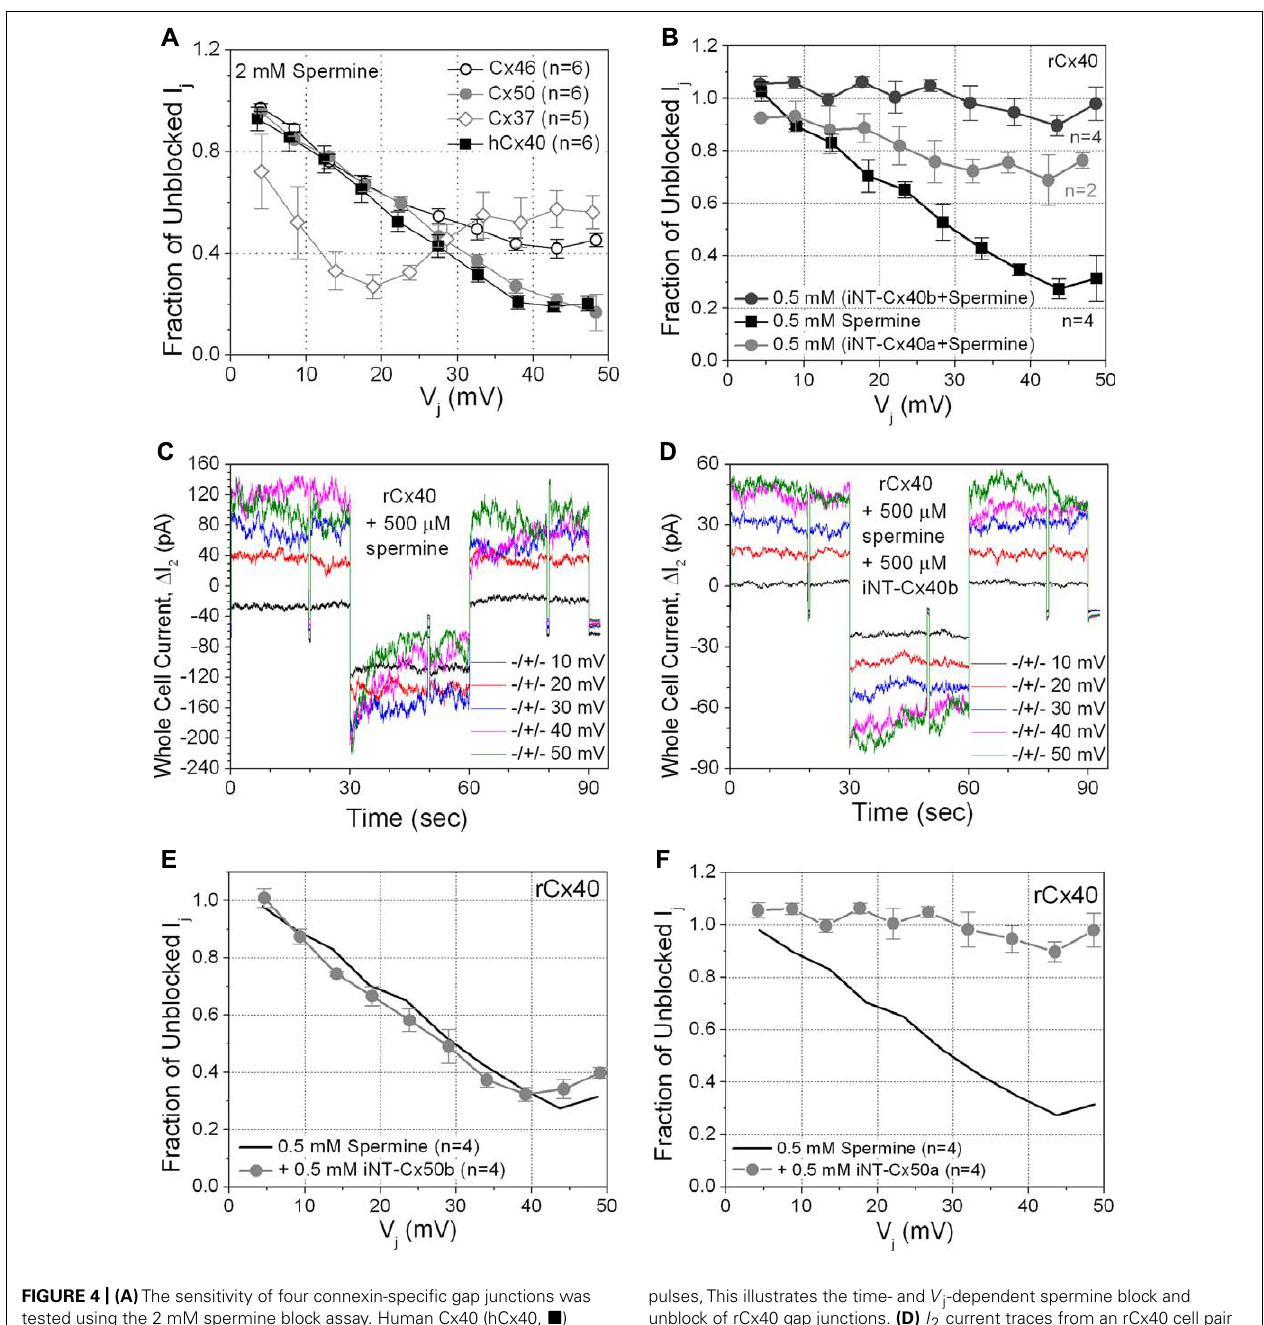
FIGURE 4 | (A) The sensitivity of four connexin-specific gap junctions was tested using the 2 mM spermine block assay. Human Cx40 (hCx40, (cid:2) ) displayed similar V j -dependent sensitivity to spermine as rCx40 despite the • ◦ (cid:8) ), Cx46 ( ), and Cx50 ( ) gap junctions were all N9 substitution. Cx37 ( ≥ 60% inhibited by spermine.The maximum inhibition of Cx37 g j occurred at + 20 mV, half the V j required for maximal block of any other known connexin-specific gap junction. (B) The ability of iNT-Cx40 peptides to interfere with spermine block was tested by adding 500 μ M spermine and iNT-Cx40a or iNT-Cx40b peptides to one patch pipette.The carboxyl- terminal hydroxylated (-OH, z = − 4) form of the Cx40 peptide (Cx40b) effectively abolished the V j -dependent spermine block, while the amidated form (Cx40a, − NH 2 , z = − 3) was only partially effective (ANOVA, f -value < 0.05). (C) Δ I 2 current traces from an rCx40 cell pair with 500 μ M spermine added to cell 1. I j decreased during the positive 30, 40, and 50 mV V j pulses and returned to prepulse levels during subsequent negative V